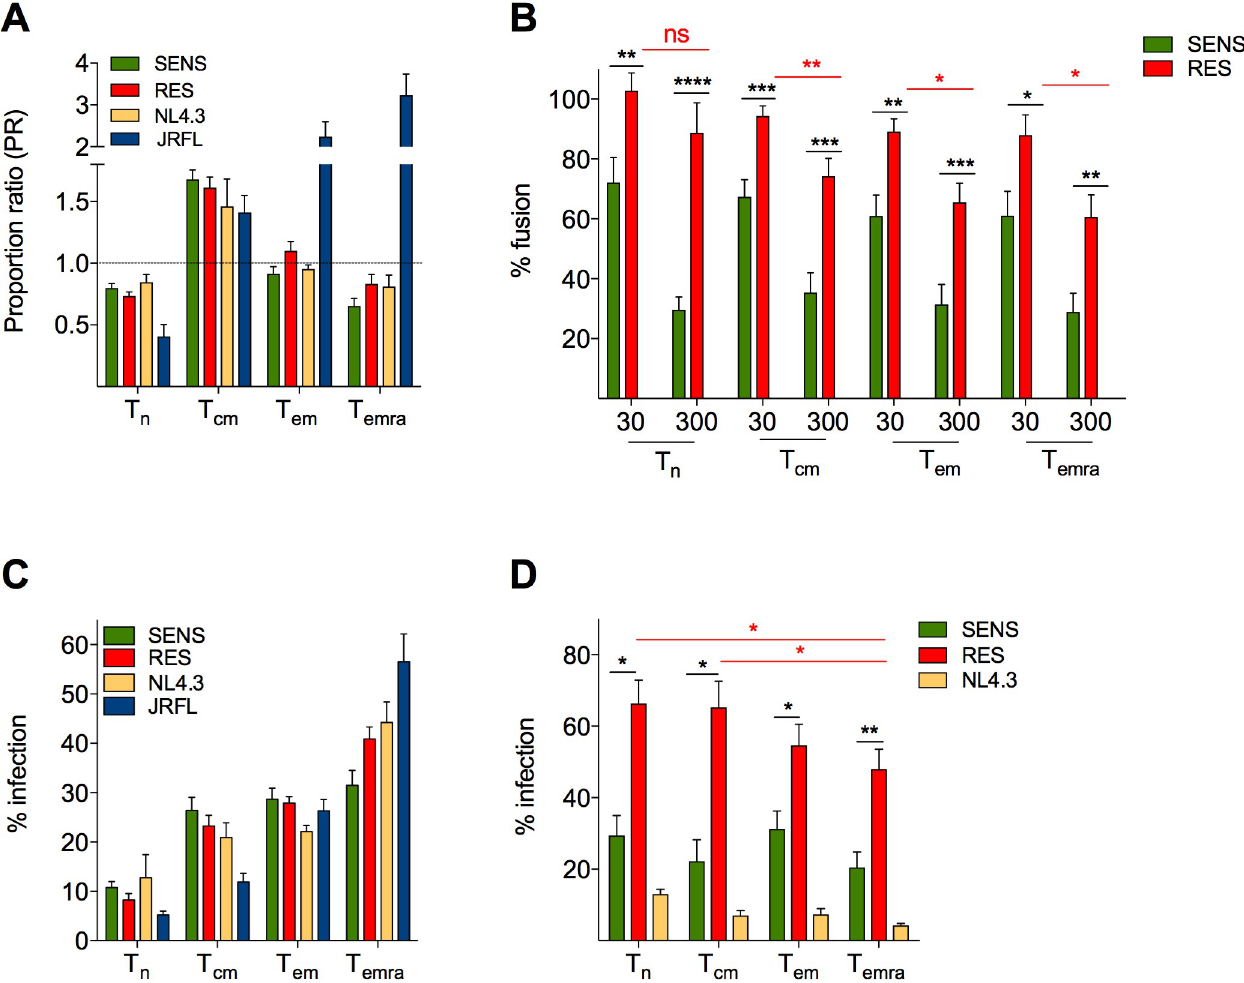
Fig 5. CXCL12 protects CD4TL subsets against SENS viruses, but not against RES viruses. A Tropism of SENS and RES viruses for Tn, Tcm, Tem and Temra CD4TL. For each cell subset, the panel represents its proportion (PR) within CD4TL that have fused with viruses, compared to its proportion among all cells (infected and uninfected cells). BLaM-vpr-containing viruses pseudotyped with the SENS or RES Envs of P#39, #208, #1120, #8332 and #704 were used. NL4.3 (X4) and JRFL (R5) Envs served as controls. Results are means ± SEM of three independent experiments. B Fusion of SENS and RES viruses with CD4TL subsets in the absence or presence of 30 or 300 nM CXCL12. Percent fusion for each virus is expressed relative to fusion in the absence of CXCL12 (100%). C Infectivity of SENS and RES viruses in sorted CD4TL subsets. Percent infection of each T cell subset is expressed relative to infection of all CD4TL subsets (100%). Means ± SEM of three experiments are shown. D Infection experiments were repeated in the presence or absence of 300 nM CXCL12. Results are expressed relative to infectivity in the absence of CXCL12 (100%).